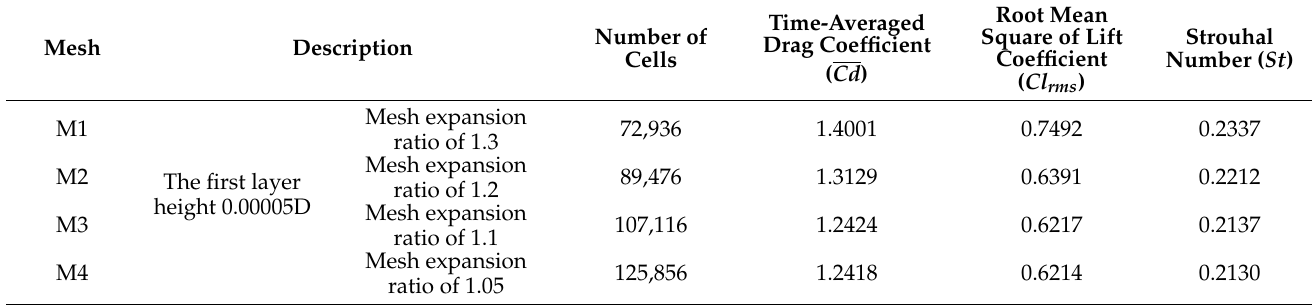
Table 2. Grid independence verification for the smooth cylinder at Re = 1 × 10 5 .